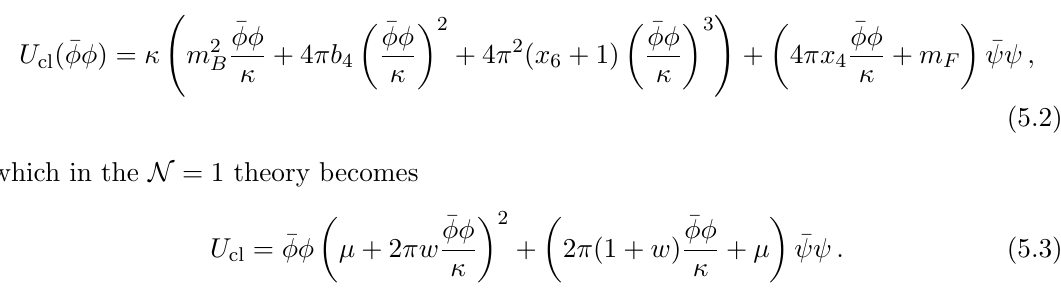
Figure 18. The phase diagram ellipsoid of the N = 2 theory for the value j (cid:21) j = 1 blue lines are described by regular fermion CFTs and the solid blue lines are critical boson CFTs. The (cid:12)rst order phase transition line in green is on the far side of the ellipsoid. Note that the (cid:12)rst order line meets the dashed blue line and solid blue line at one point in the northern hemisphere and at one point in the southern hemisphere. These meeting points are presumably governed by a combination of critical fermion and regular boson CFTs i.e. an RB-CF CFT. The intersection point of the two solid and two dashed blue lines is described by the CB-RF CFT. The three special points, one on the equator, one in the northern hemisphere and one in the southern hemisphere are all expected to be described by CFTs that are self-dual under the duality